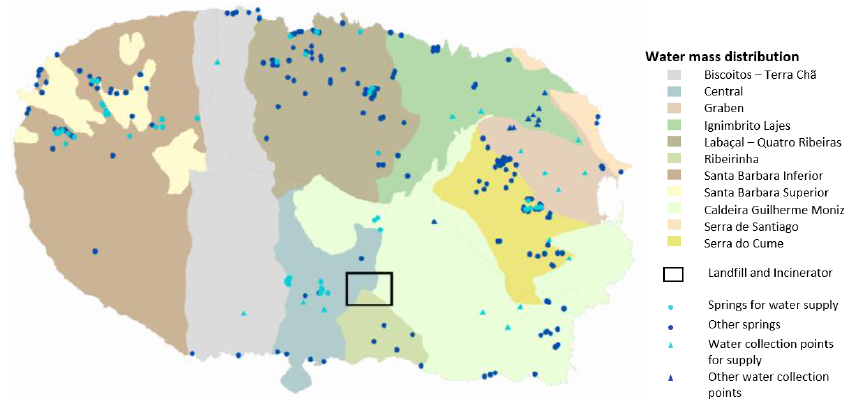
Fig. 11. Water mass distribution and water supply network in Terceira Island [43].